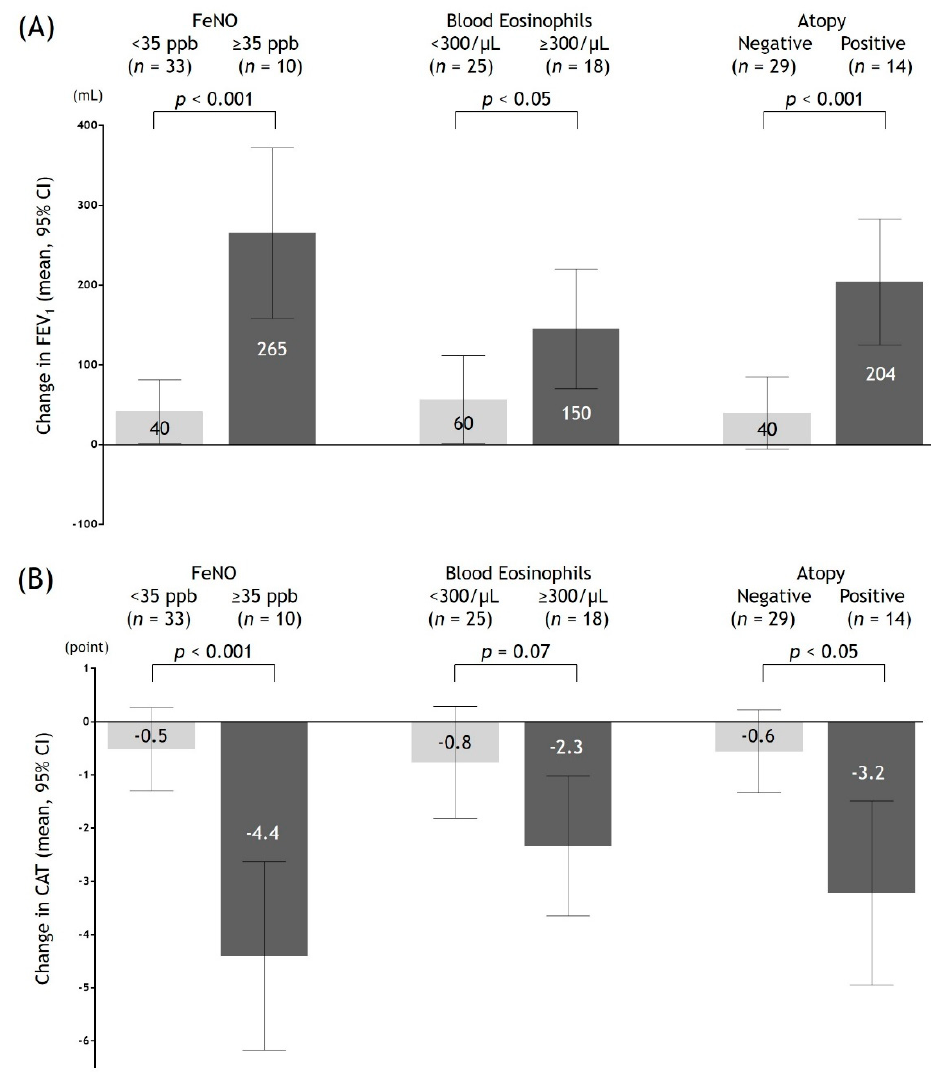
Figure 2. Changes in the mean values (95% CI) of FEV1 ( A ) and CAT ( B ) by 12 weeks of add-on therapy with inhaled corticosteroids, stratified based on the criteria for type 2 inflammations in Japanese guidelines for ACO. Abbreviations: FeNO, exhaled nitric oxide fraction; FEV1, forced expiratory volume in 1s; CAT, chronic obstructive lung disease assessment test; CI, confidence interval; ACO, asthma–COPD overlap.